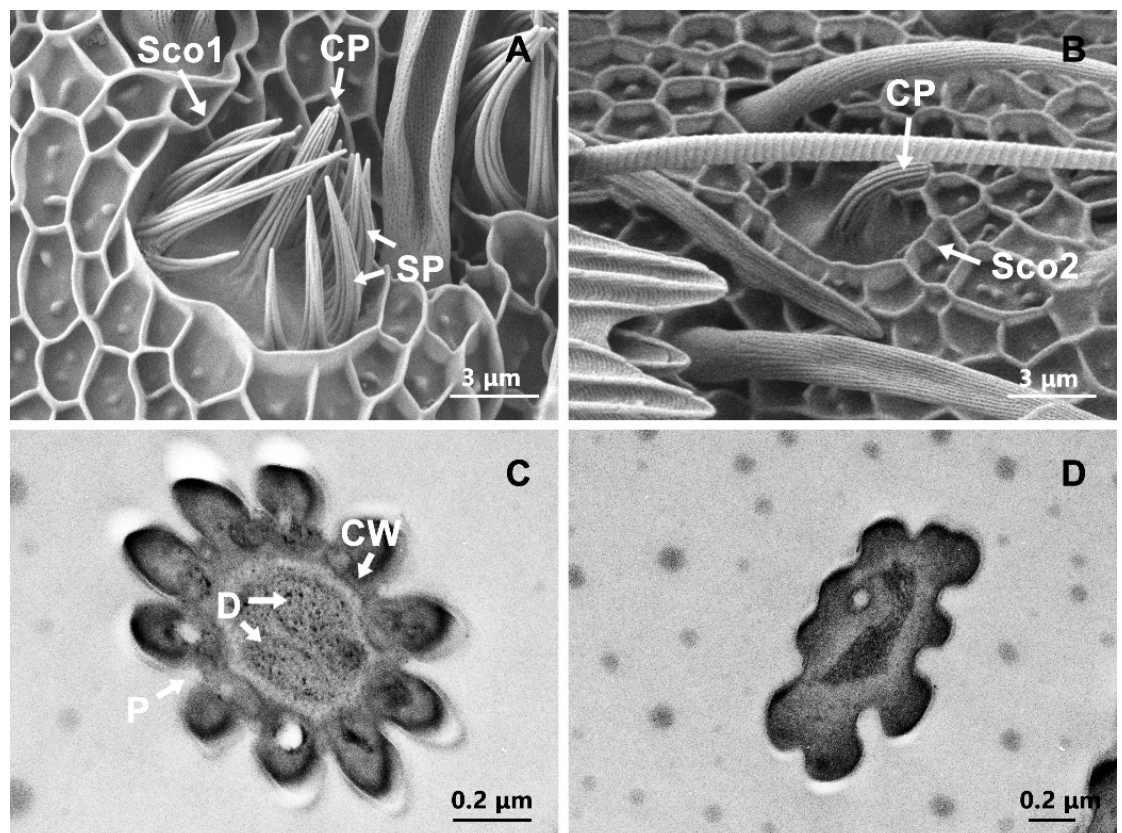
Figure 7. Scanning electron micrographs and transmission electron micrographs of sensilla coe- loconica 1 (Sco1) and sensilla coeloconica 2 (Sco2). ( A ) Structure characters of Sco1; ( B ) structure characters of Sco2; ( C ) transverse section of the central peg; ( D ) transverse section of the spine. CP: central peg; SP: spine; CW: cuticle wall; D: dendrite; P: pore. 3.8. Sensilla Squamiformia (Ssq)